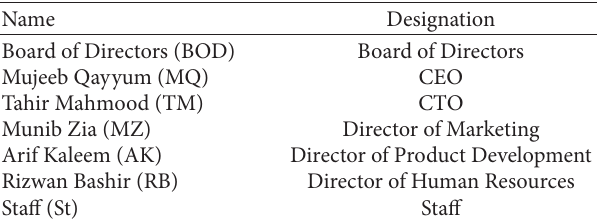
Table 1: Names of employees in an organization and their designa- tions.